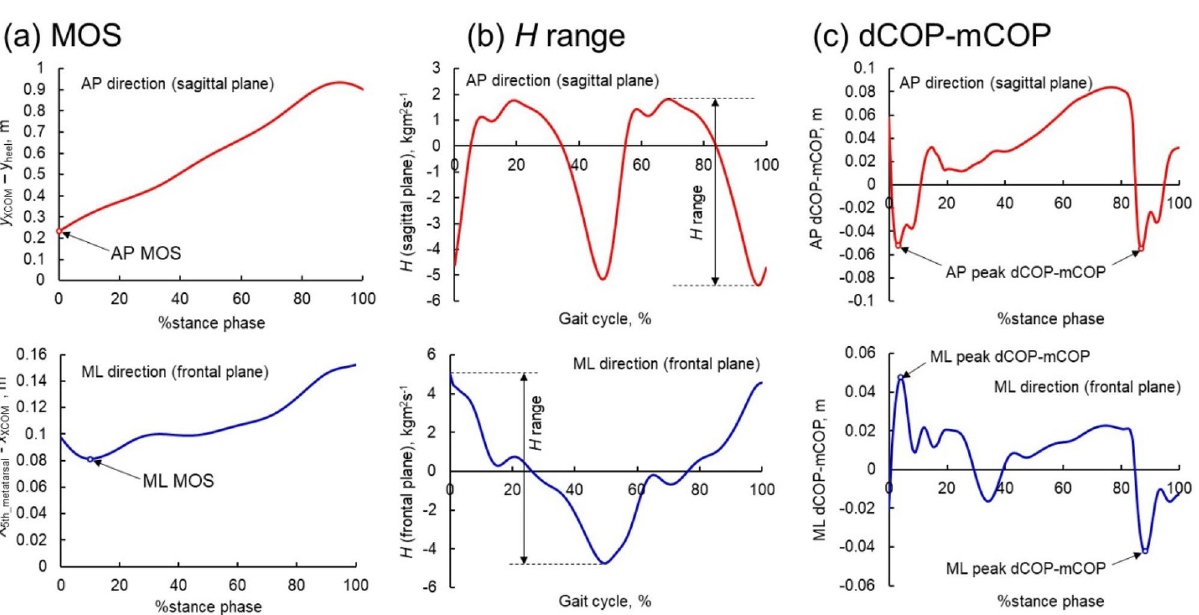
Figure 5. Representative time series for the ( a ) margin of stability, ( b ) range of H , and ( c ) dCOP–mCOP in the AP and ML directions. H whole-body angular momentum; dCOP desired center of pressure; mCOP measured center of pressure; AP anteroposterior; ML